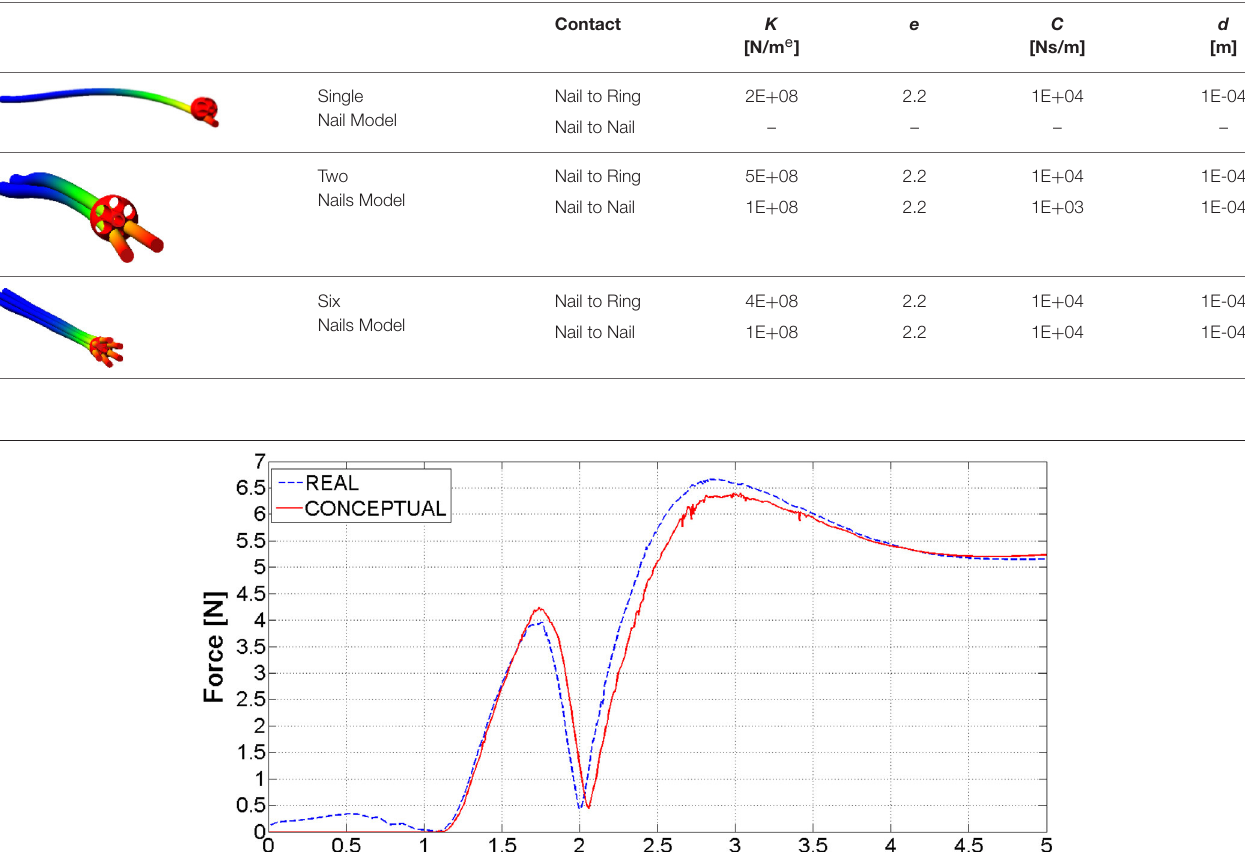
TABLE 1 | Contact parameters for the real ring geometry.